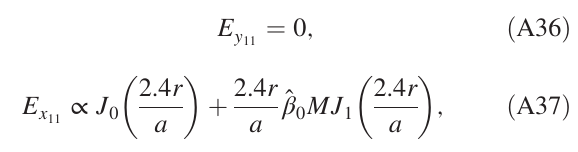
FIG. 13. An illustration of the harmonic distribution over the index n under discussion (top axis), where the dashed line depicts the expected decay in harmonic strength as we move away from the band edges (in red) that represent the dominant harmonic and its image. Given the symmetry in the Bessel functions involved in the different bands, it is sufficient to focus our treatment on the middle band, between − n 0 and 0, where k tn is real. A convenient positive integer d is introduced in the derivations, for the middle band, and is illustrated in the bottom